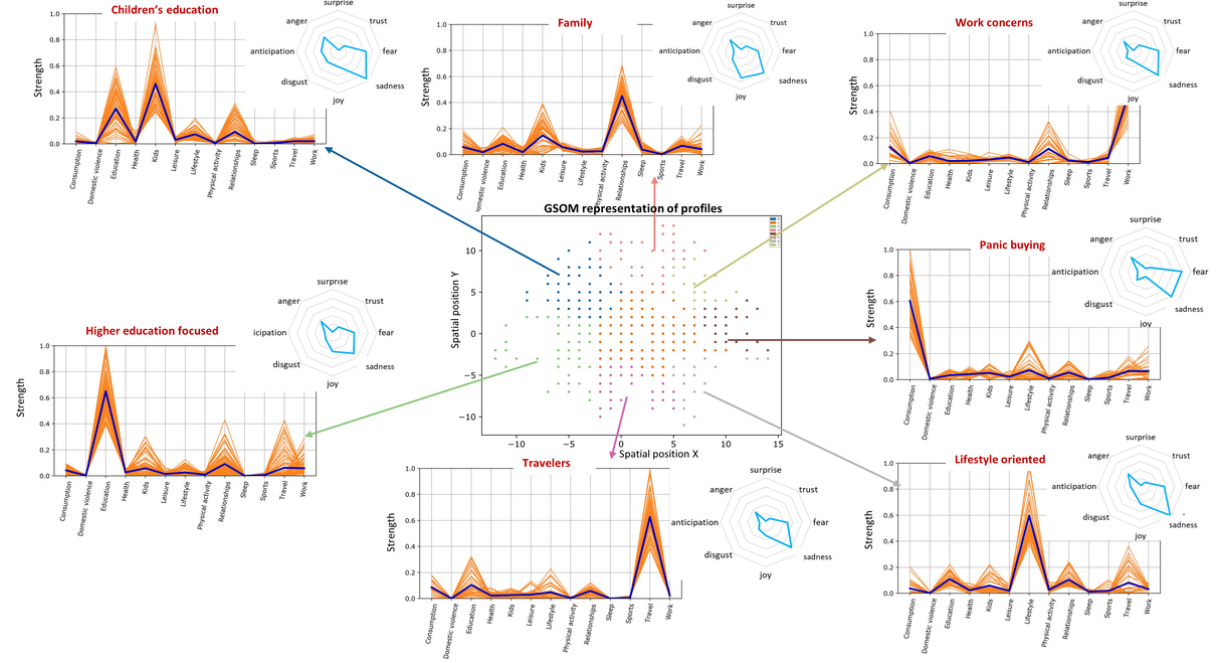
Figure 5. Behavior profiles in the first lockdown. The mean strength of each concern is denoted as a blue line. GSOM: growing self-organizing map.